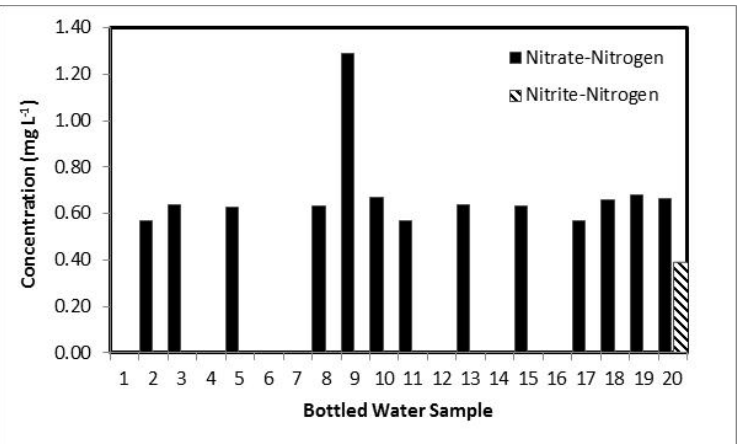
Figure 1. Nitrate-nitrogen and nitrite-nitrogen levels measured in the bottled water